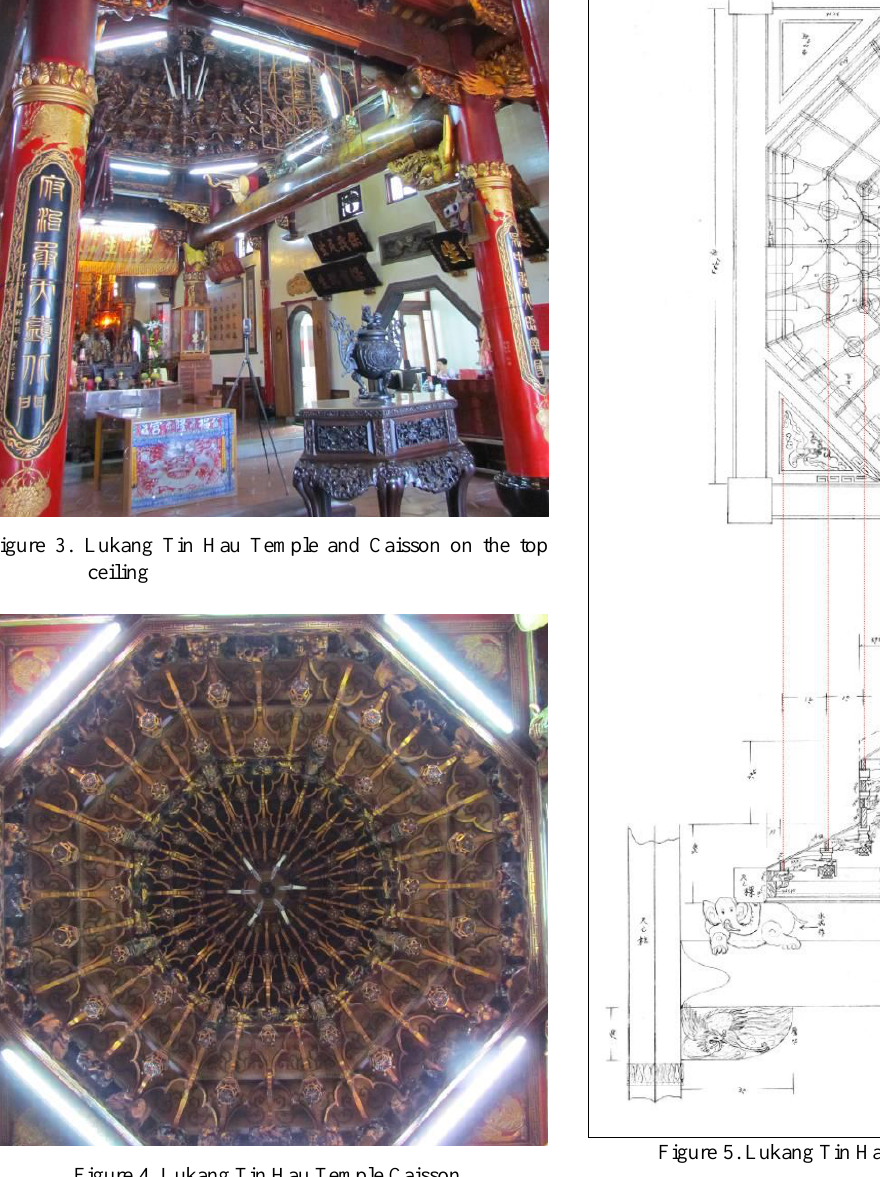
Figure 4. Lukang Tin Hau Temple Caisson